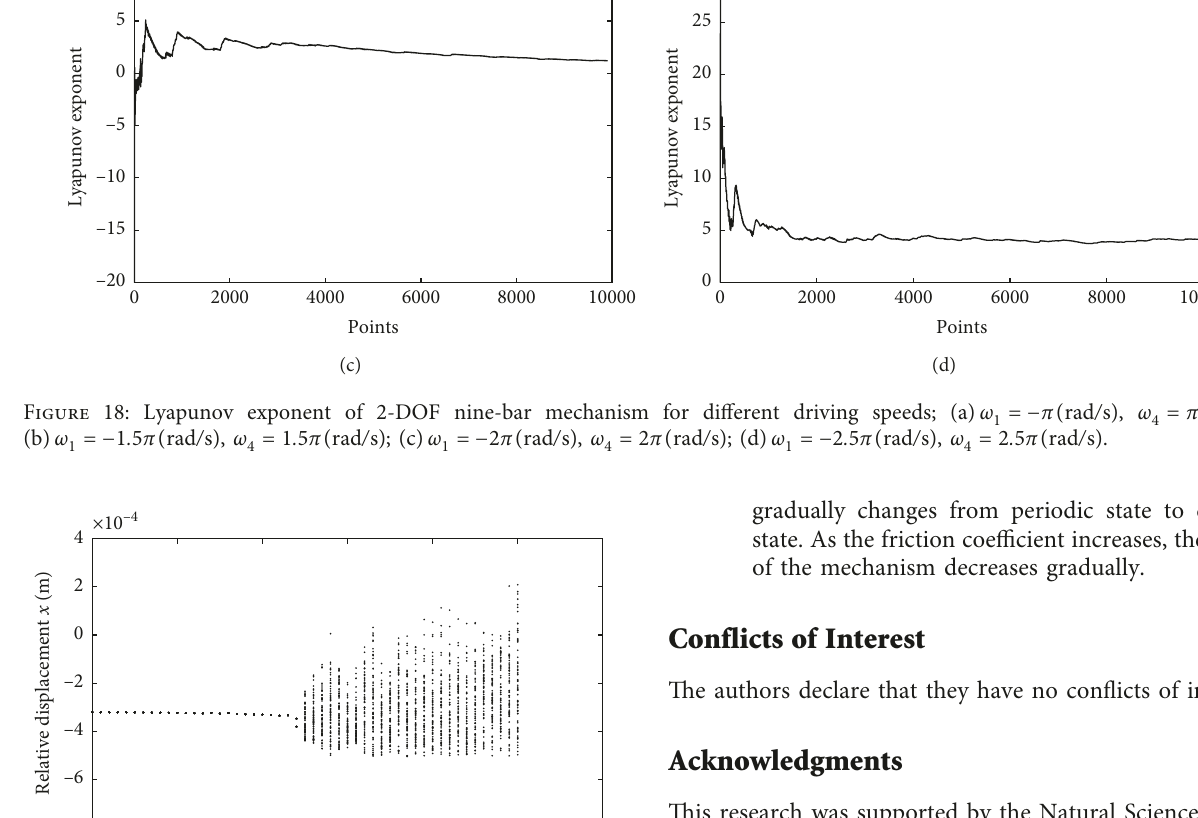
� 1 . 5 π ( rad / s ) ; (c) ω 4